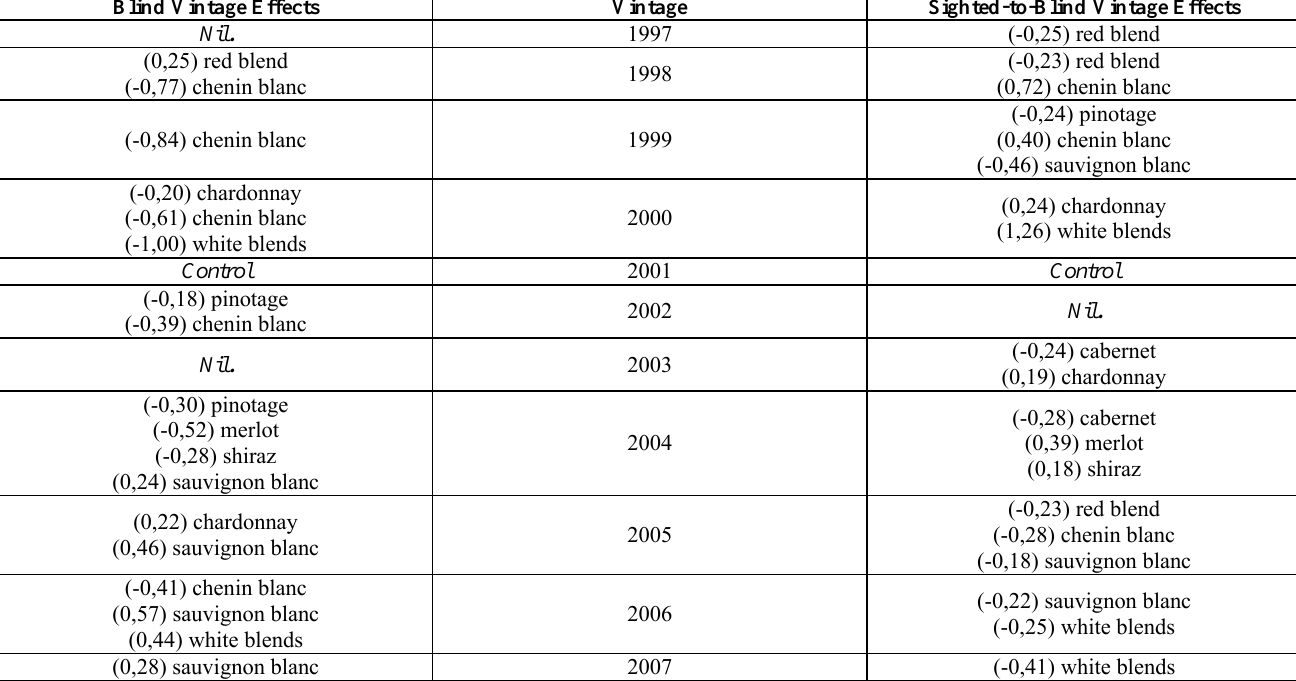
Table 11: Vintage effects as per the twenty models developed. Note 2001 is the control year. Blind Vintage